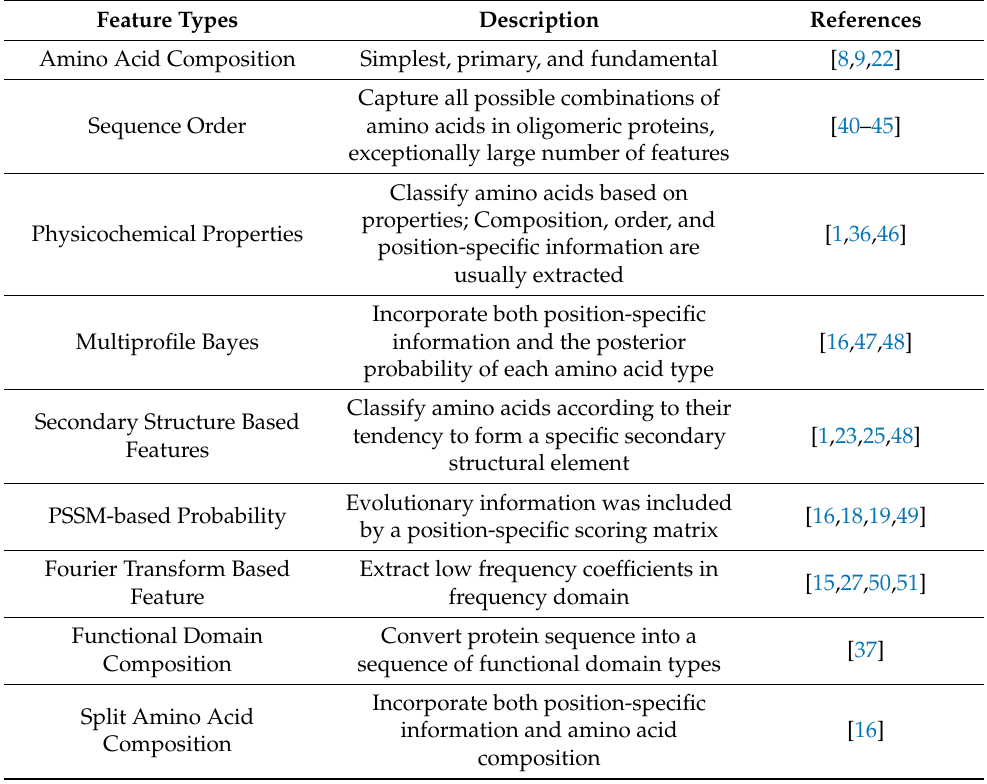
Table 2. List of features applied to represent